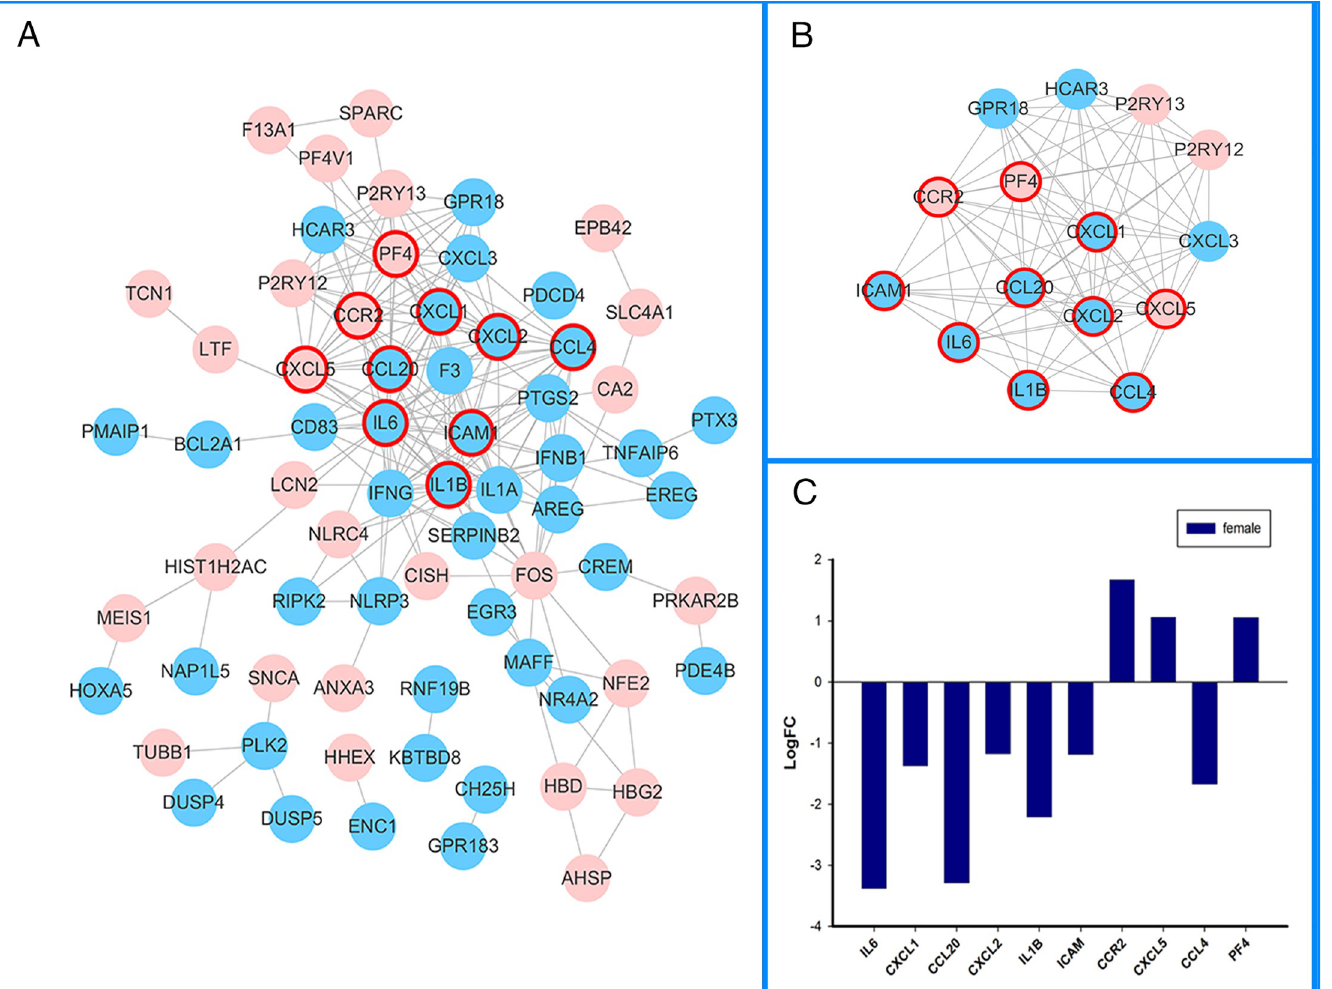
Fig 2. Female-specific PPI networks in IS. A. Pink circles represent upregulated DEGs, blue circles represent downregulated DEGs, thicker red border emphasizes CytoNCA topologically significant DEGs. B. MCODE cluster of PPI networks. C. Top 10 CytoNCA significant DEGs. The isolated DEGs indicated no experimentally validated or predicted protein-protein